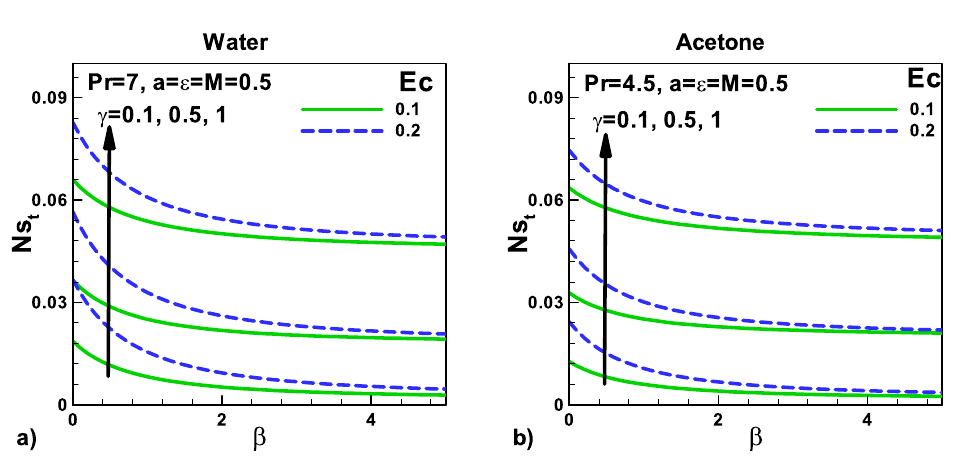
Figure 9. Variation of total entropy generation rate with velocity and thermal slip parameters for ( a ) water ( b )